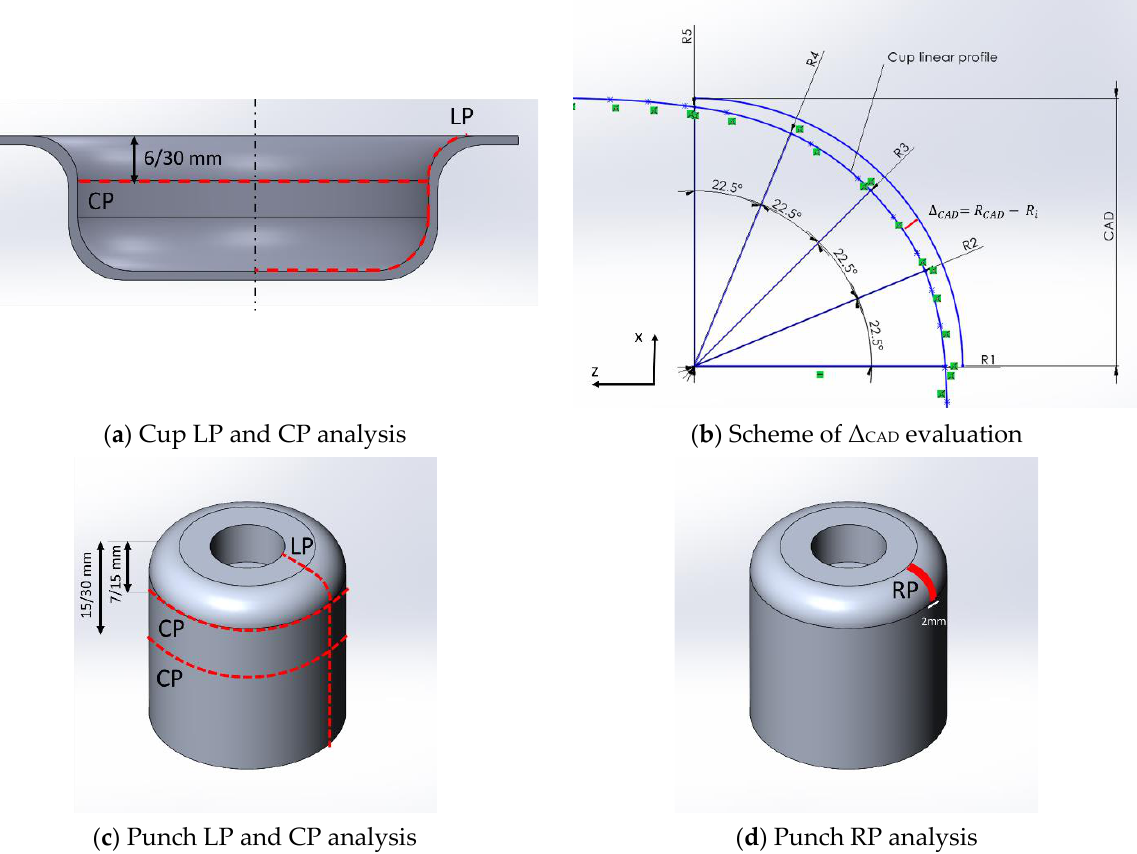
Figure 2. Methods adopted to analyze the experimental results.